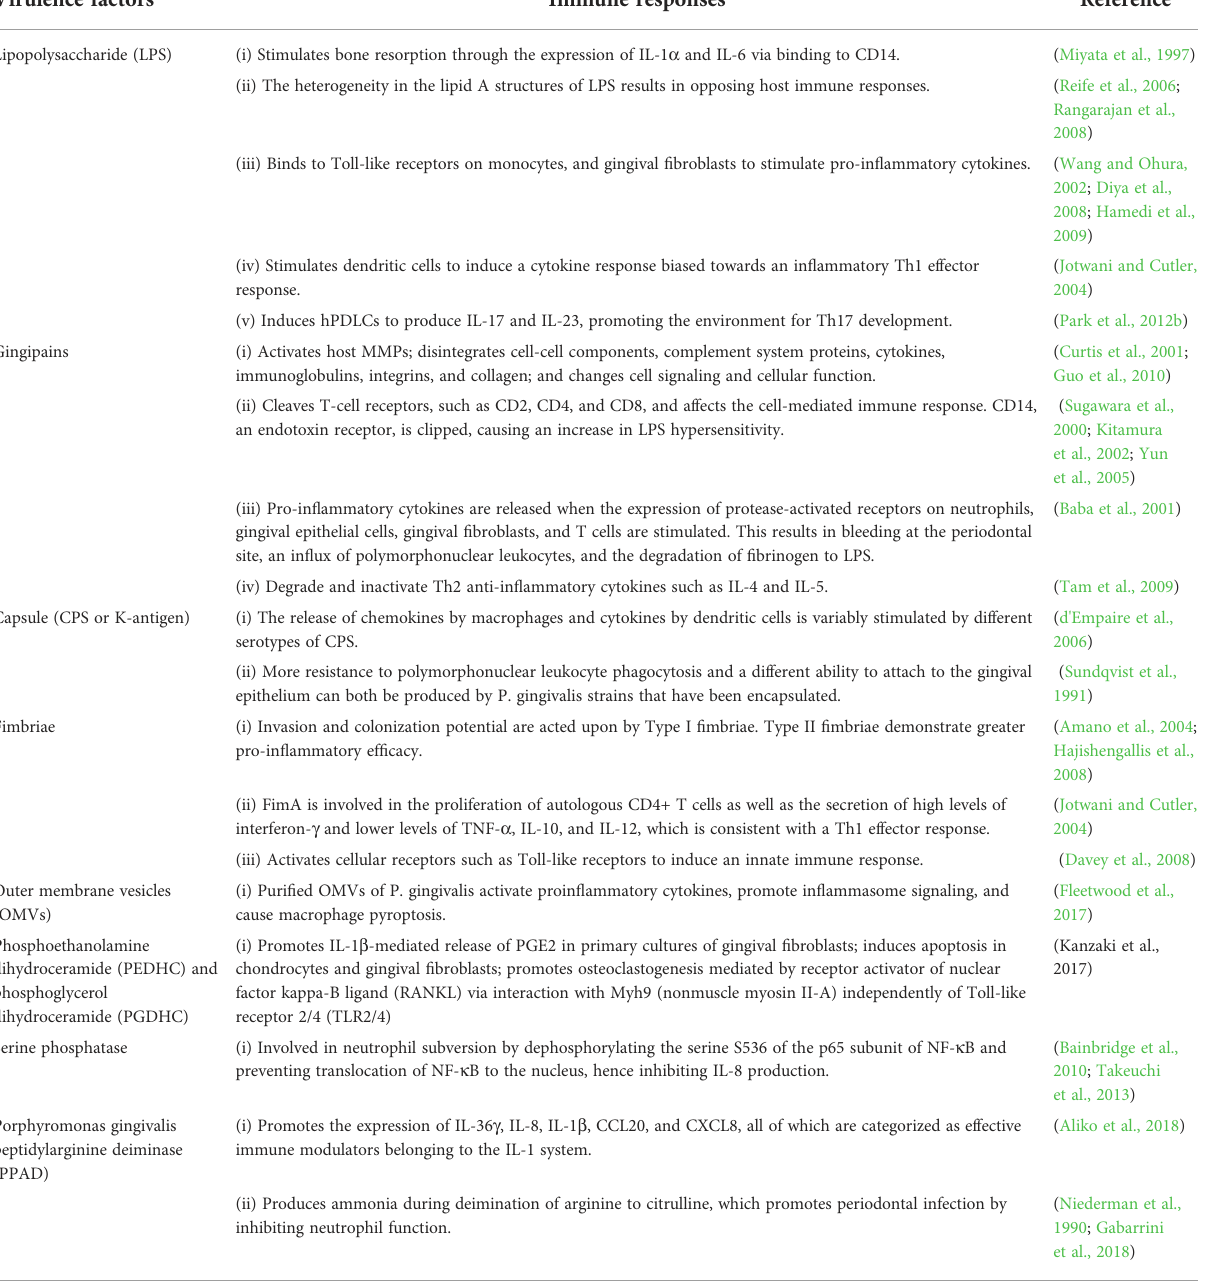
TABLE 2 Immune responses to virulence factors of P. gingivalis